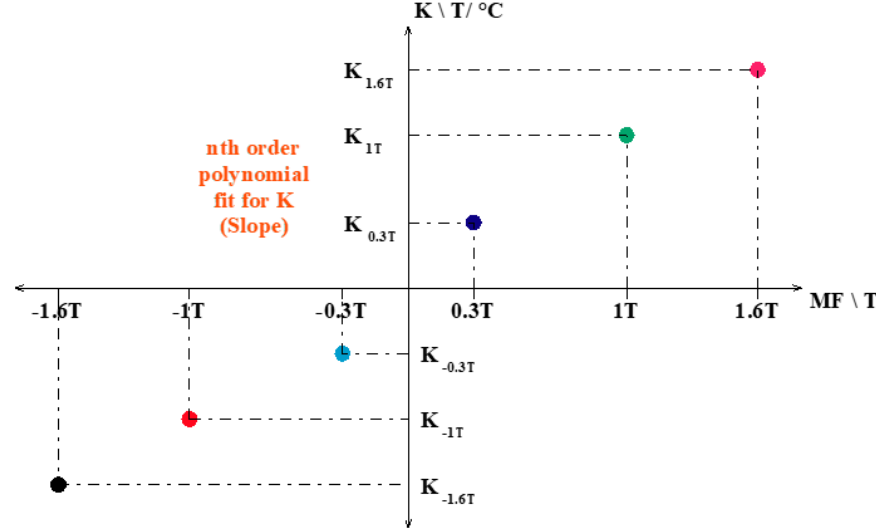
Figure 12. Plot showing the theoretical relation that is obtained between the magnetic field values given by the instrument with respect to the slopes values of the error ( K xT ). This relation must be modelled using an nth order polynomial.